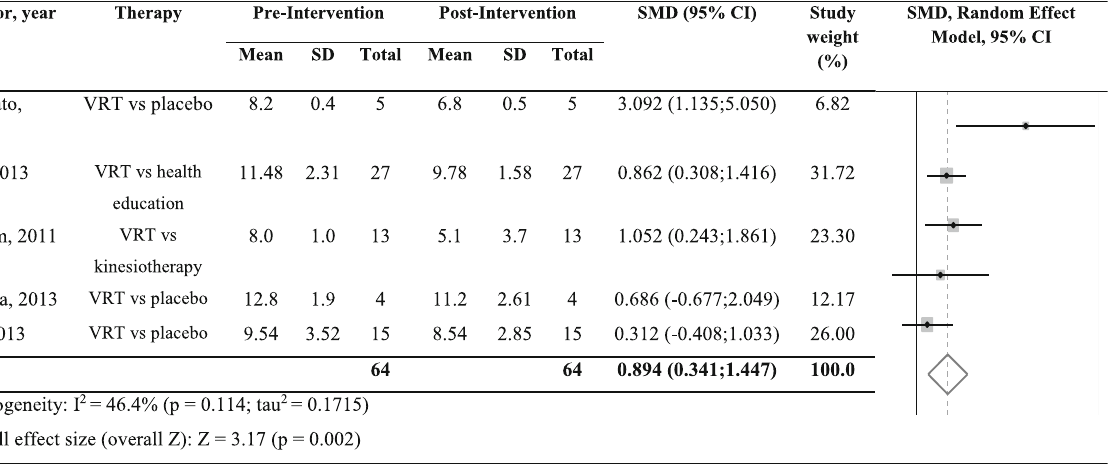
(TUG) test, grouping data from five studies ( N =